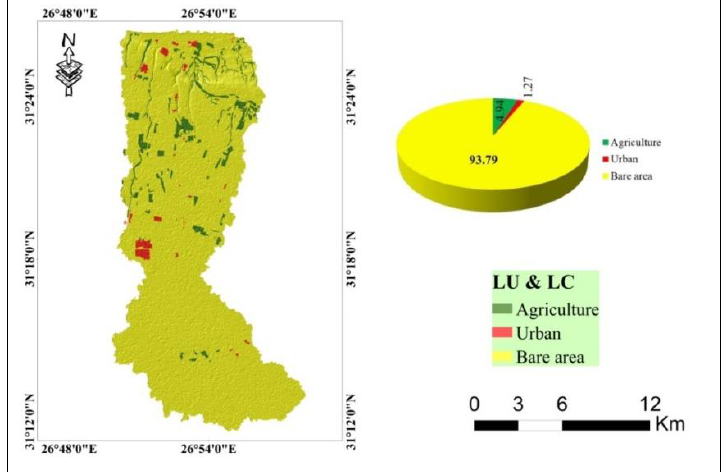
Figure 4. Land use (LU) and land cover (LC) of the study area.